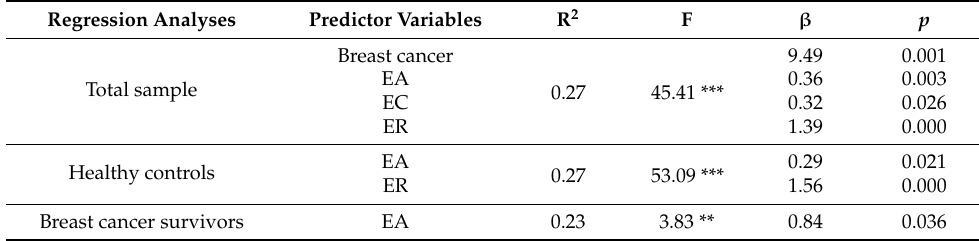
Table 2. Summary of regression analyses.